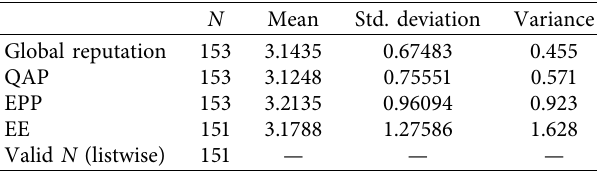
Table 3: Descriptive statistics (construct means).